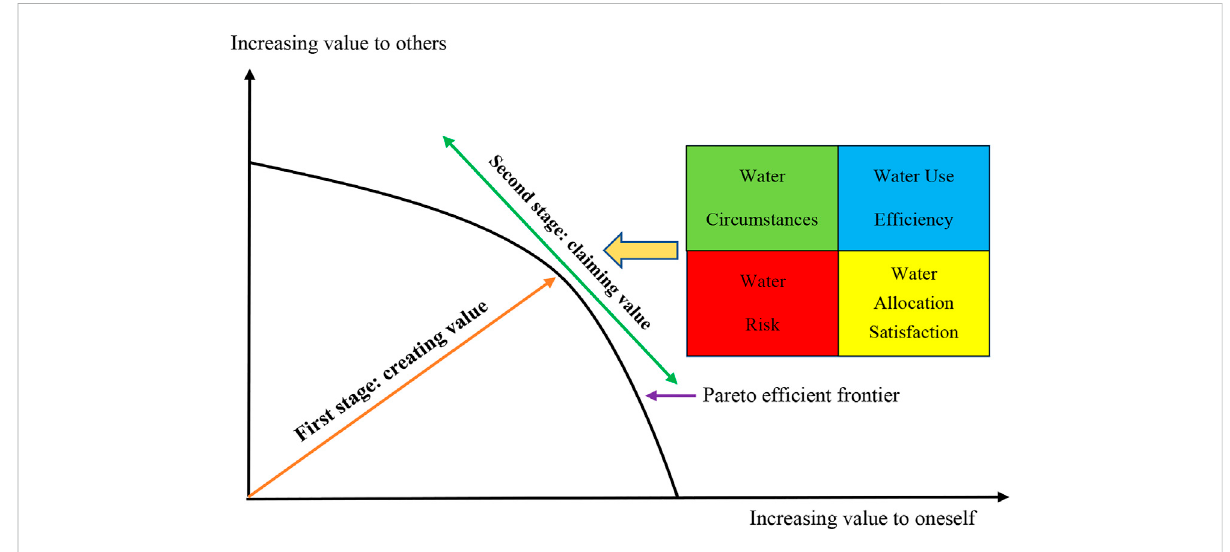
FIGURE 1 Sketch of the two-stage water resources allocation decision-making